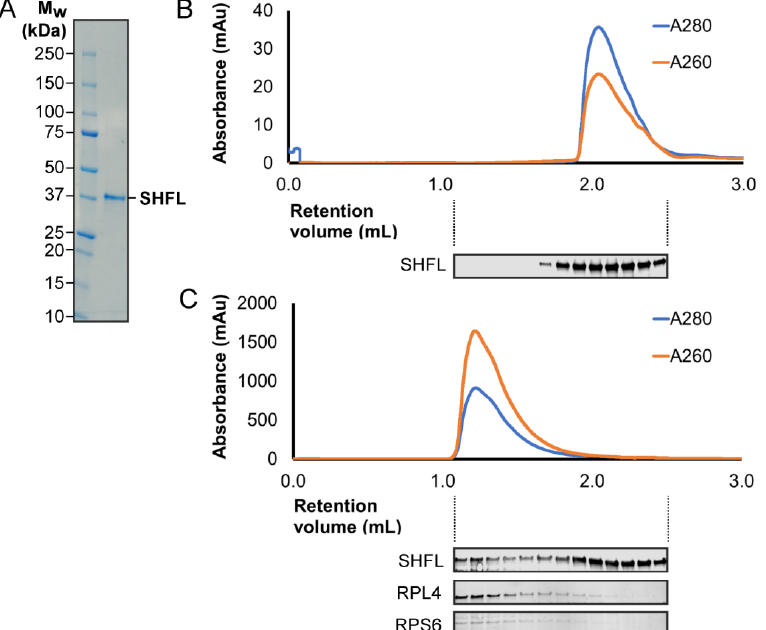
Figure 2. Characterization of purified SHFL and association with mammalian 80S ribosomes . ( A ) SDS-PAGE analysis of purified SHFL. ( B ) Size-exclusion chromatogram of purified SHFL (37 µM). Fractions across the peak were analyzed by immunoblot for SHFL. ( C ) As ( B ) following the incubation of SHFL (18 µM) with RRL 80S ribosomes (1 µM; purified according to [57]). Fractions across the peak were immunoblotted for SHFL and ribosomal proteins uL4 and eS6. Note, in panel ( C ), the absorbance readings are dominated by 80S ribosomes.